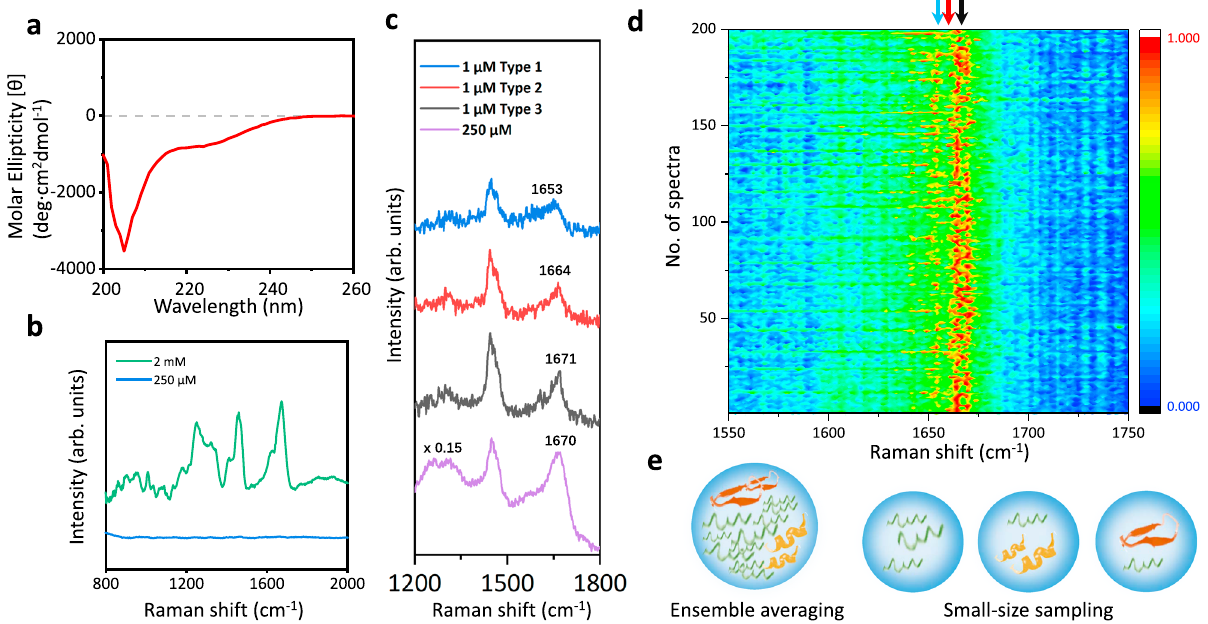
Fig. 5 The spectroscopic characterizations of an intrinsically disordered protein: alpha-synuclein. a CD spectrum of 200 μ M alpha-synuclein in aqueous solution. b Spontaneous Raman spectra of 2 mM (green) and 250 μ M (blue) alpha-synuclein solution with 10 min acquisition time. c The comparison among three representative types of SERS spectra of 1 μ M alpha-synuclein solution with 1 s acquisition time (blue, red, and black) and the SERS spectrum of 250 μ M alpha-synuclein solution with 5 min acquisition time (purple). d Mapping of 200 SERS spectra of 1 μ M alpha-synuclein solution obtained from two AgNP-coated beads trapped at 20 nm with 1 s acquisition time. The color bar shows the normalized intensities from low (dark blue) to high (red). e Illustration of the ensemble averaging from the measurement of alpha-synuclein at high concentration with long accumulation time and the small-size sampling from the measurements of alpha-synuclein at low concentration with short accumulation time. Source data are provided as a Source data fi